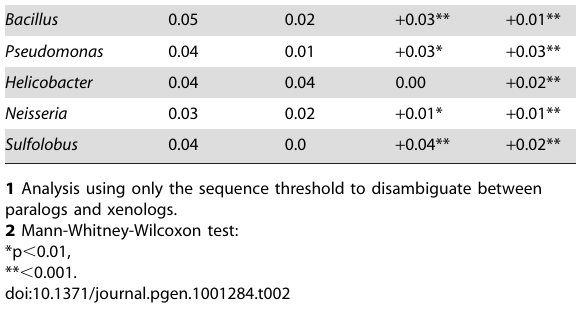
With positional